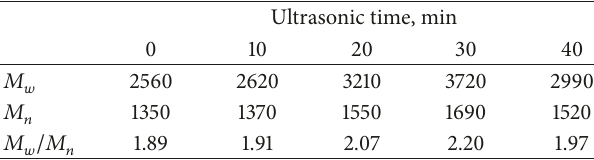
Table 3: The molecular weight and the polydispersity of lignin obtained at different ultrasonic